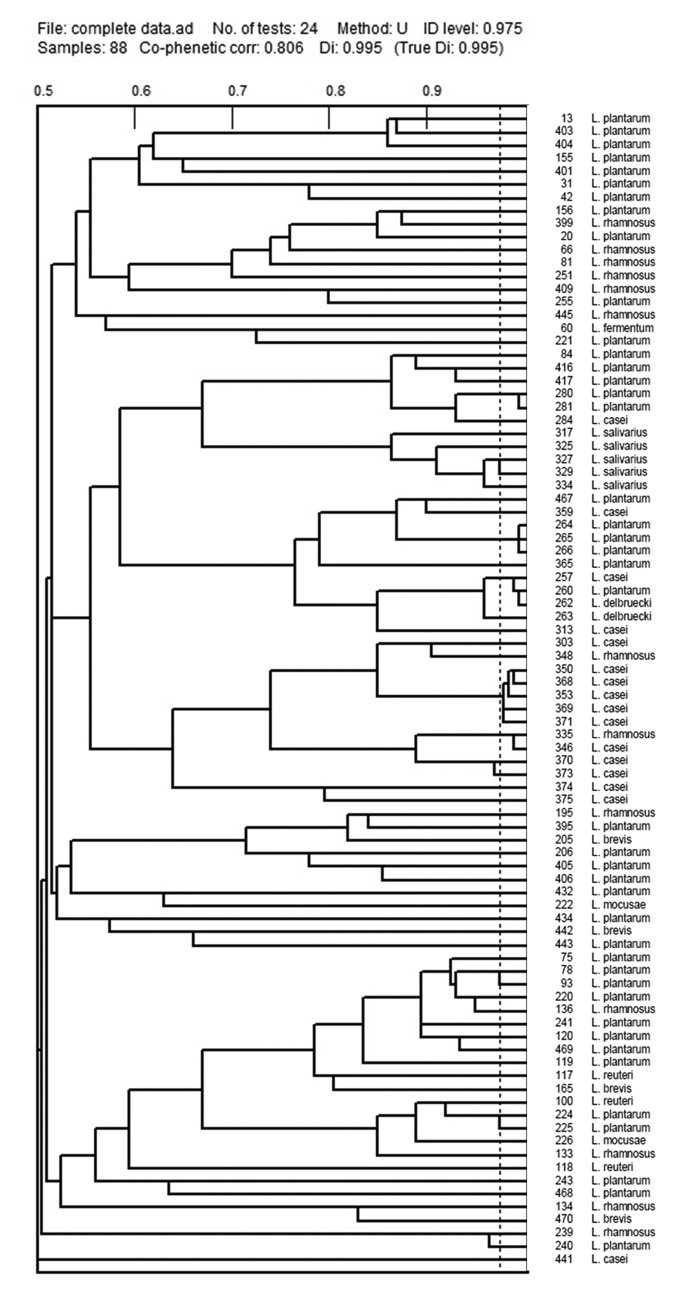
Phenotypic clustering of isolated Lactobacillus sp. with PHP-plate assay.